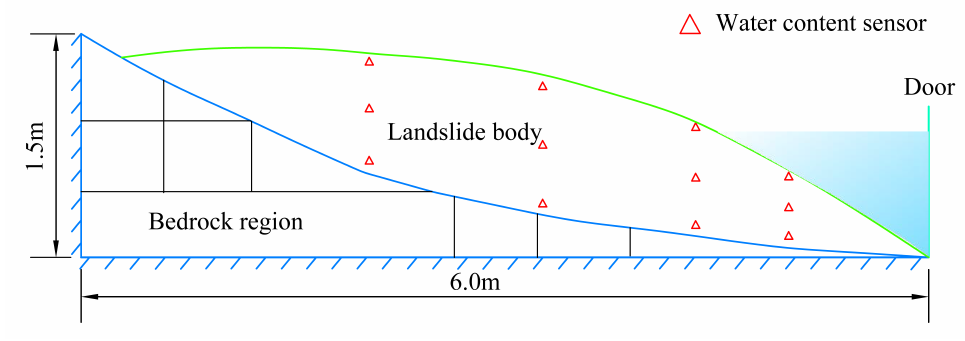
Figure 3. The side view of the landslide model and configuration of instruments in the experiment. A drawing of the configuration of the experimental model, showing the bedrock region (within blue lines), the landslide body region (below the green line), and the embedded sensors to monitor the water content.